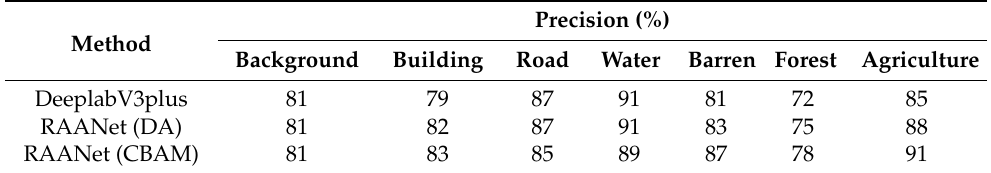
Table 6. Precision comparison of DeeplabV3plus, RAANet (DA), and RAANet (CBAM). Precision (%) Method Background Building Road